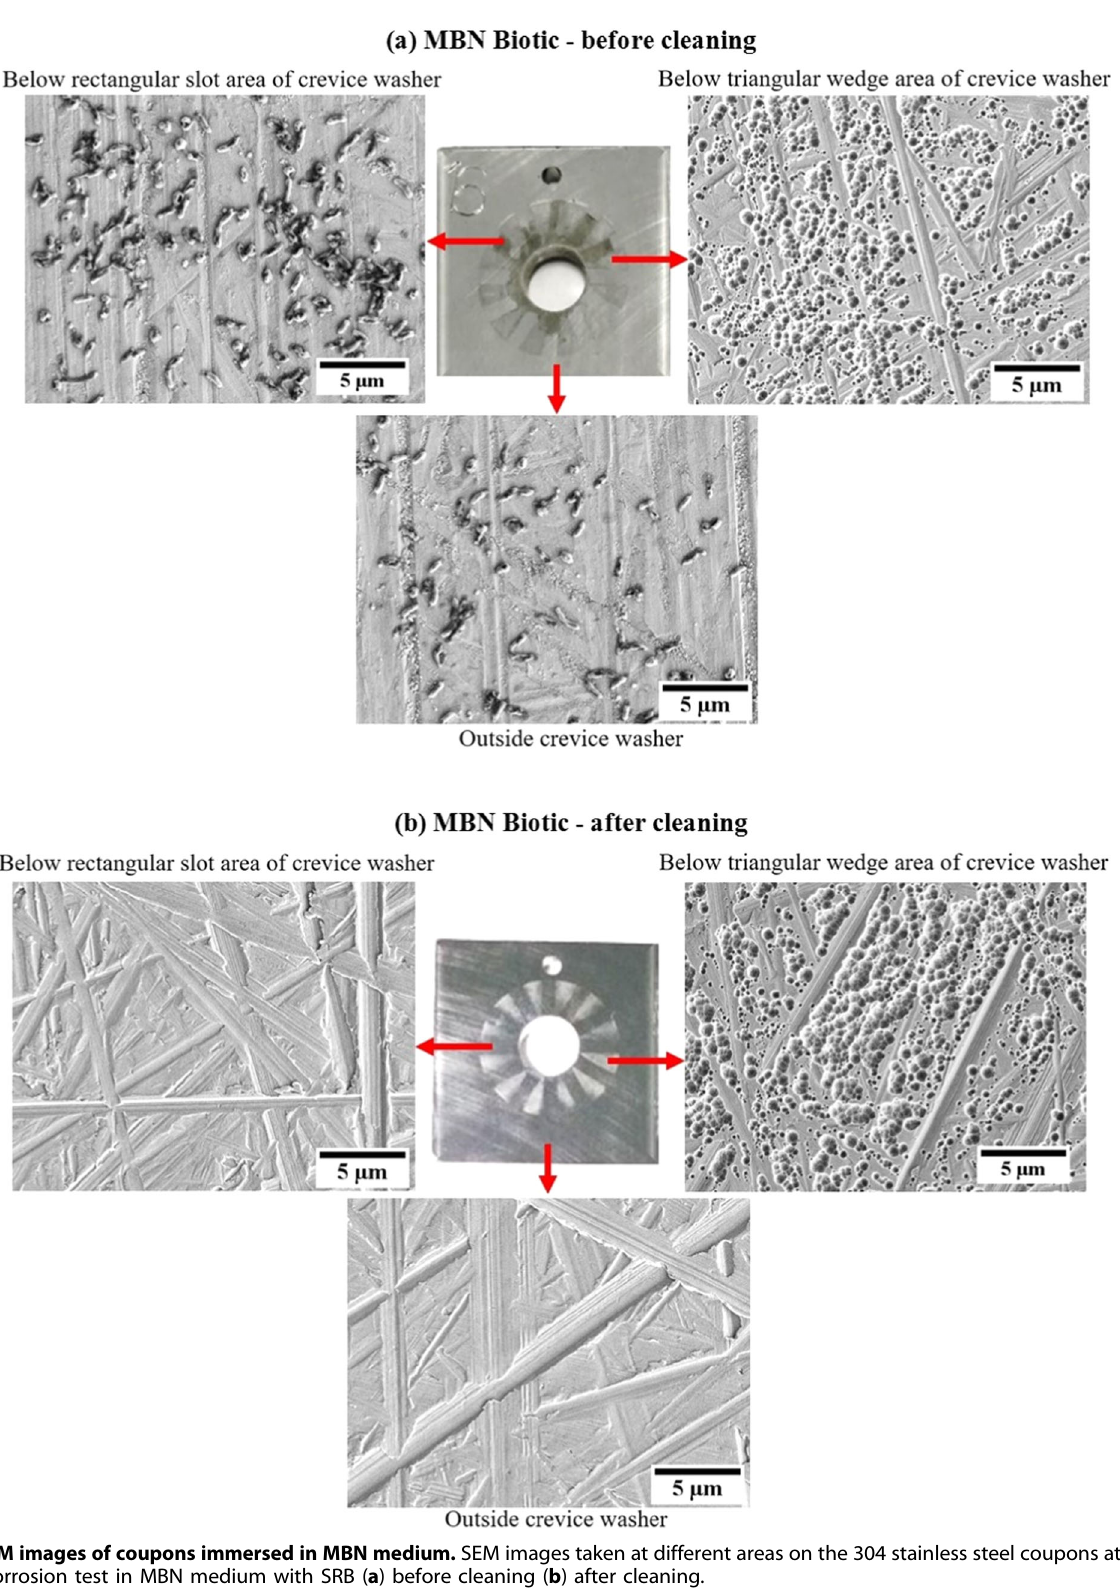
Fig. 4 SEM images of coupons immersed in MBN medium. SEM images taken at different areas on the 304 stainless steel coupons at the end crevice corrosion test in MBN medium with SRB ( a ) before cleaning ( b ) after cleaning. shows an example of typical black color SRB colonies grown on The number of viable SRB cells (CFU mL − 1 ) was measured at the agar plate. The estimated number of viable SRB cells was similar in end of the experiment to see if there was any correlation between both the MBN and MB medium i.e. 10 7 CFU mL − 1 . During the the numbers of SRB present in the different media used and the observed crevice corrosion of stainless steel. Supplementary Fig. 2 plating tests, no evidence of microbes other than the SRB being Published in partnership with CSCP and USTB npj Materials Degradation (2022)